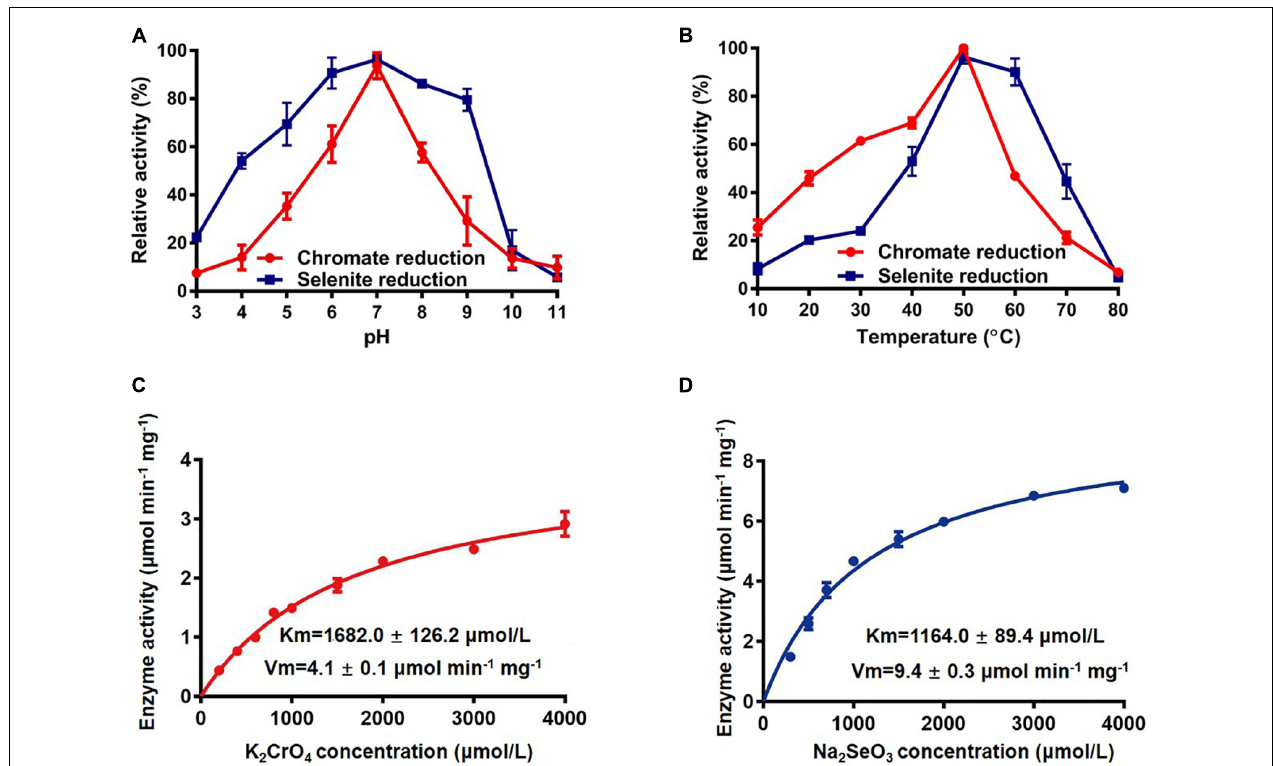
FIGURE 6 | The enzymatic reaction rate of FesR. Effects of pH (A) and temperature (B) on the enzymatic activity. The Cr(VI) (C) and Se(IV) (D) reduction enzyme kinetics were determined at pH 7.0 and 50 ◦ C. Data are the means ± SD of three replicates.